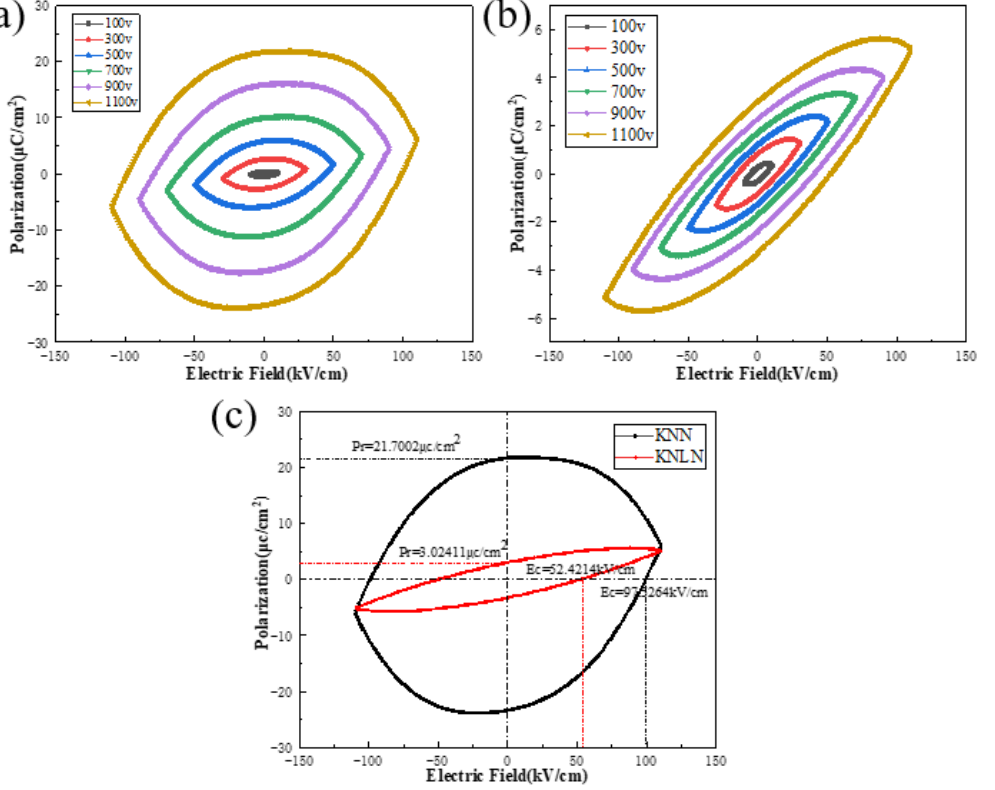
Figure 5. Polarization–electric field hysteresis loops of the ( a ) KNN and ( b ) KNLN coatings under different polarization voltages and ( c ) 1100 v polarization voltage.